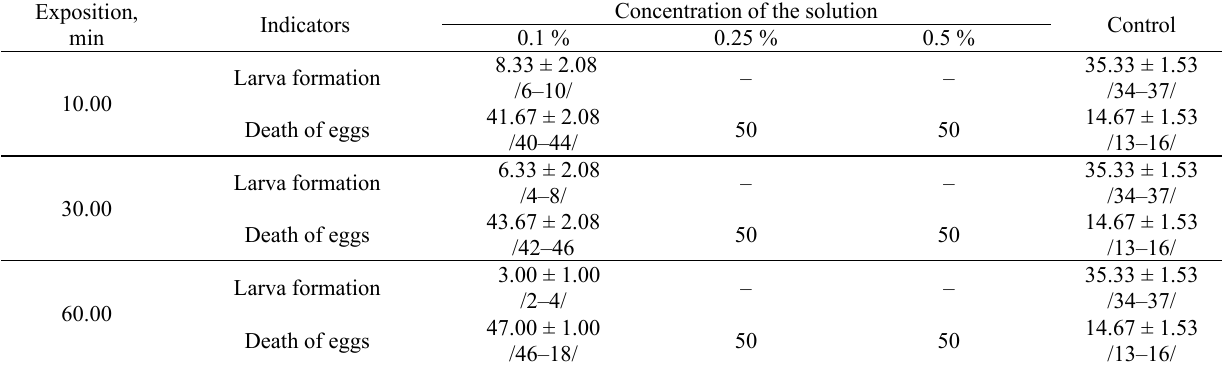
Table 2 Indicators of the ovocidal activity of “Hermecid-VS” against Passalurus ambiguus eggs during their embryogenesis in laboratory conditions (M ± SD,